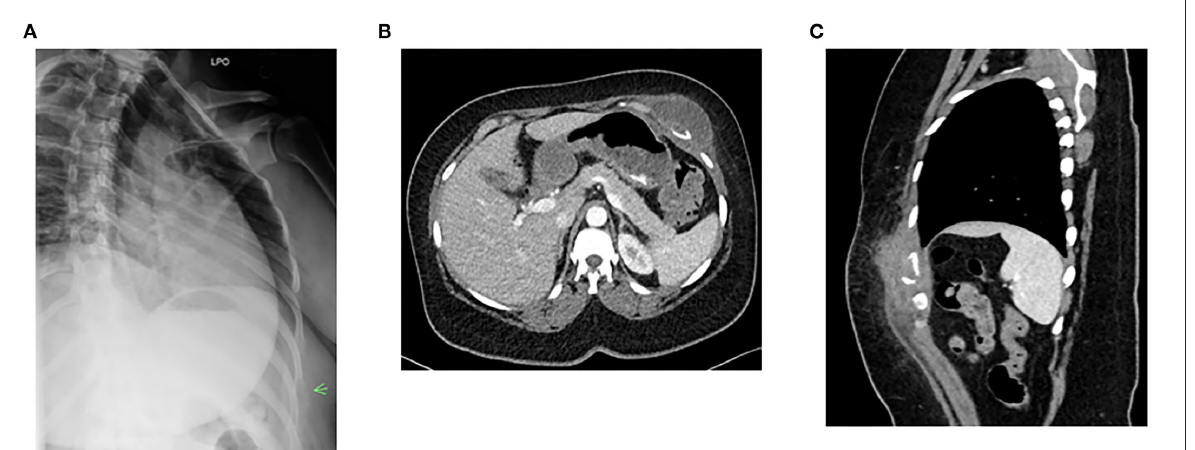
6 had subacute to chronic skin and/or soft tissue lesions (Table 1). The skin and soft tissue cryptococcal lesions